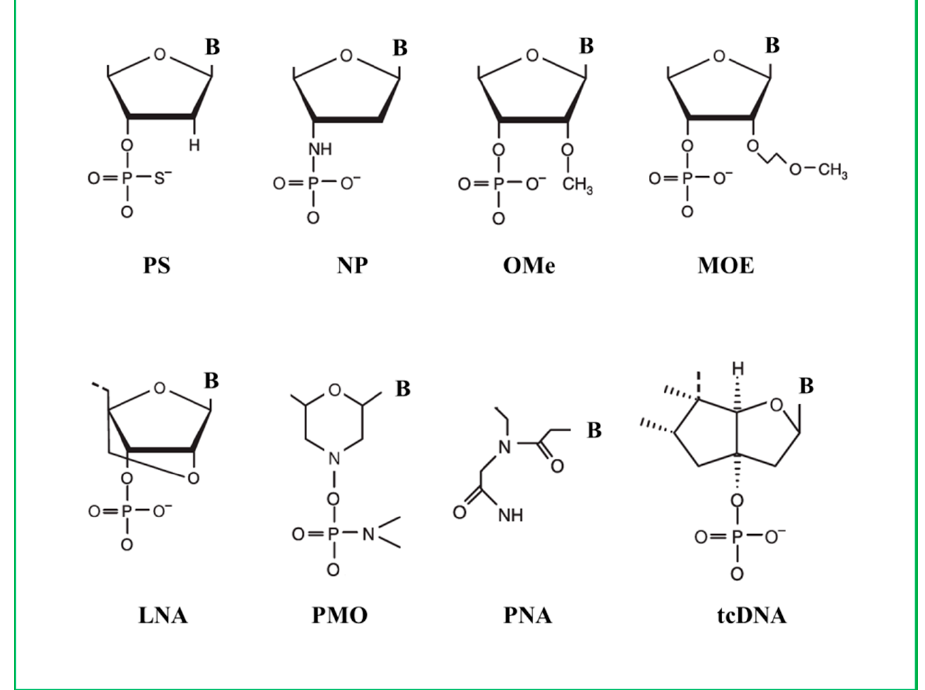
Figure 1. Chemical modifications of ASO backbone. PS, phosphorotioate; NP, N3 ′ -P5 ′ phosphoroamidate; OMe, 2 ′ - O -methyl; MOE, 2 ′ - O -methoxy-ethyl; LNA, locked nucleic acid; PMO, phosphoroamidate morpholino; PNA, peptide nucleic acid; tcDNA, tricyclo DNA.